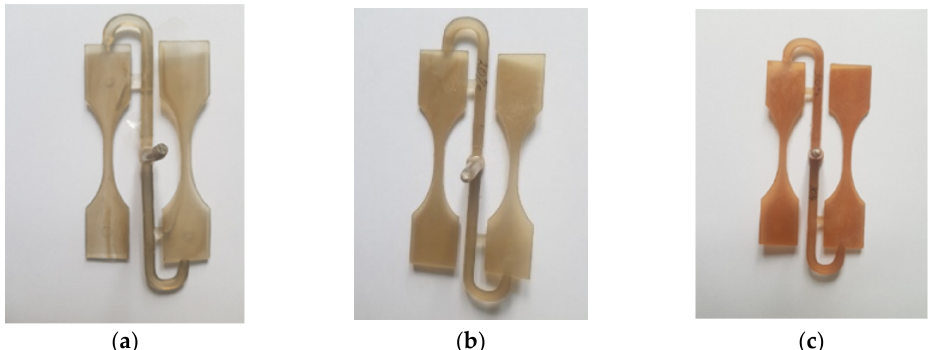
Figure 1. Test samples of composites: ( a ) unfilled; ( b ) filled with 20% short glass fibers; ( c ) filled with 30% short glass fibers.